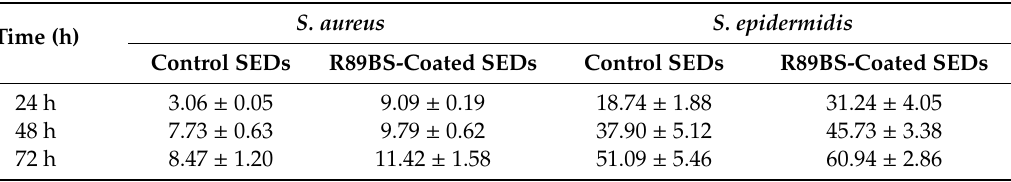
Table 4. Mean absorbance values (A 570 ) ± standard deviation obtained in the MTT assays for evaluation of live cells in the supernatants of R89BS-coated silicone elastomeric discs (SEDs) and control SEDs at the di ff erent time